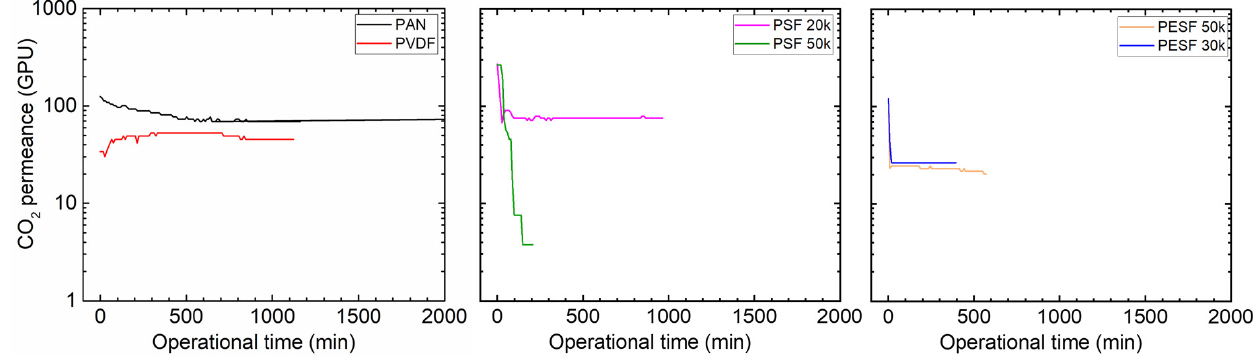
Figure 14. CO 2 permeance of PVA thin-film composite membrane coated on 6 selected supports with a feed pressure of 2 bar at 35 °C, 100%RH.